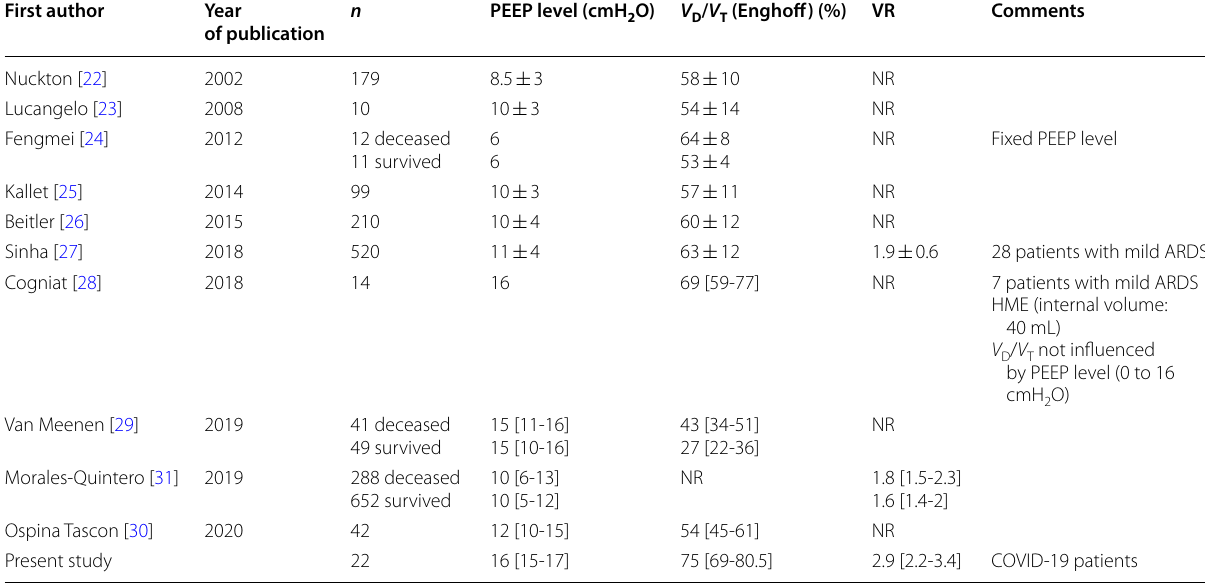
/ V (Enghoff) and VR in non-COVID-19 ARDS D T